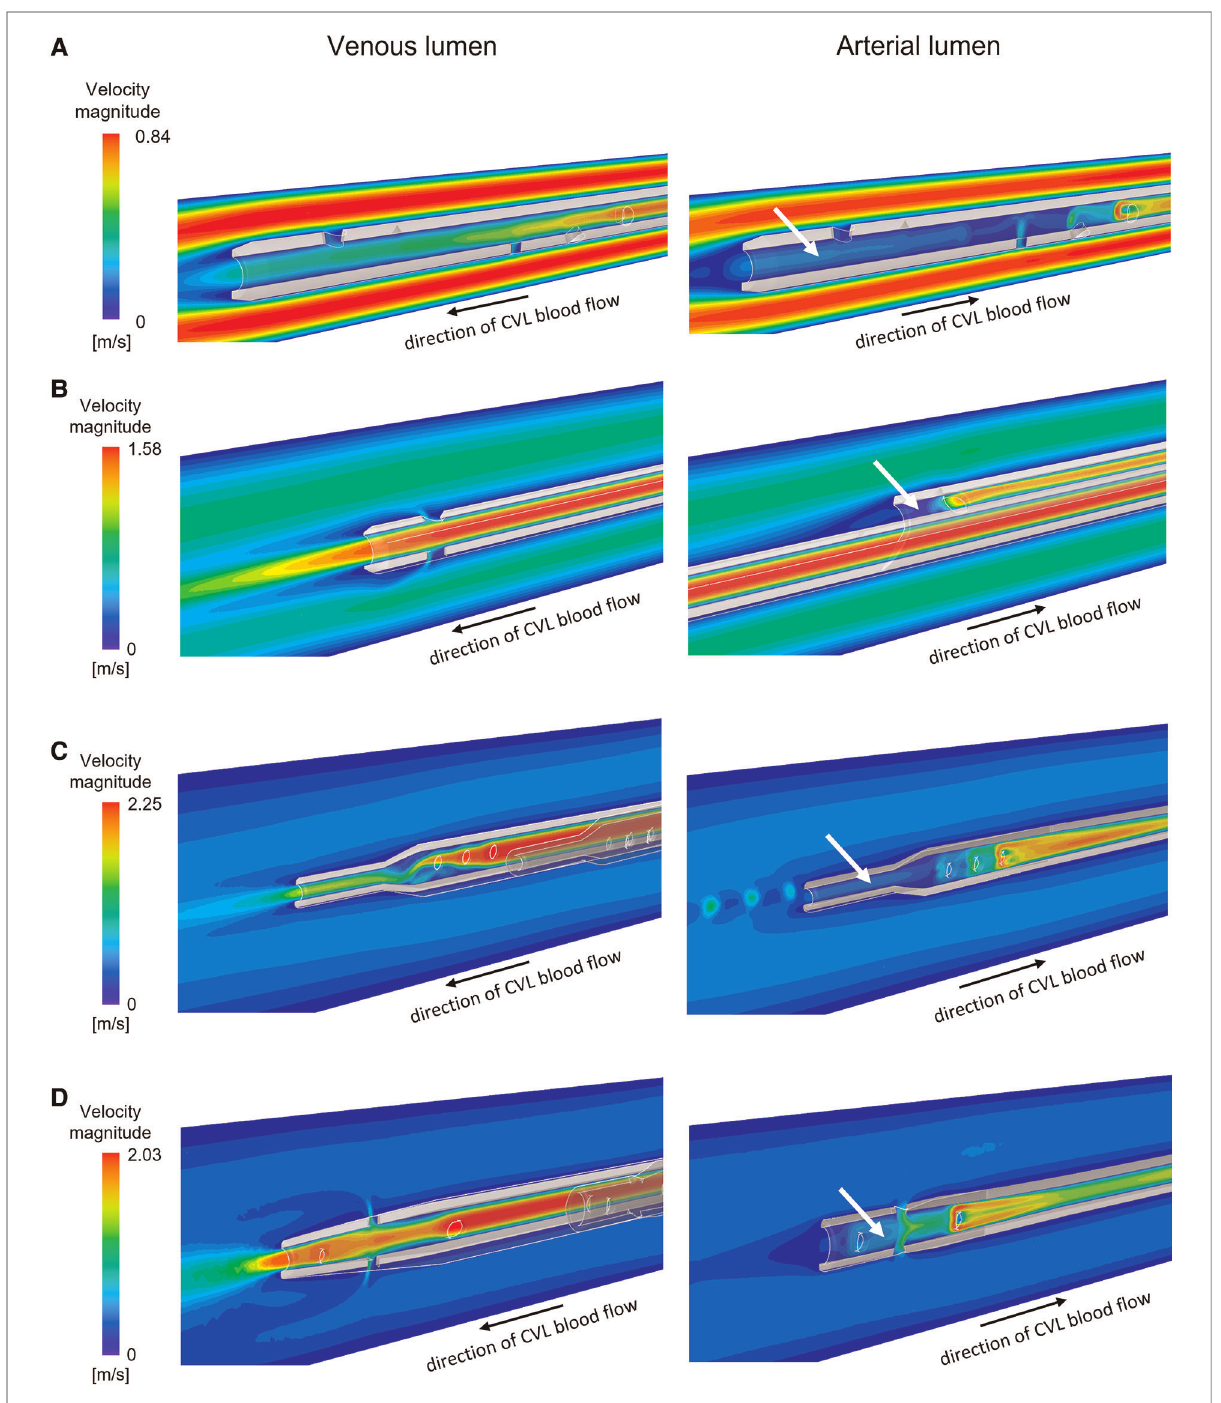
FIGURE 3 Velocity maps plotted for intermediate fl ow rates on the vertical section of the venous and the arterial lumen for the CVLs: ( A ) Tesio; ( B ) Hemo-Cath; ( C ) Pediatric Split Cath; ( D ) Split Cath III. White arrows indicate regions of low velocity inside the arterial lumen. CVL=Central venous